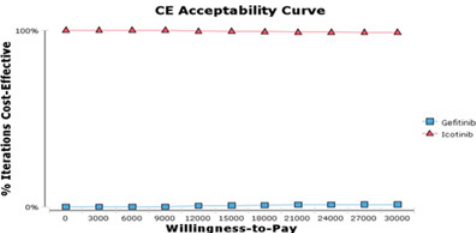
Fig 3. Cost-utility Acceptability Curve of Icotinib and